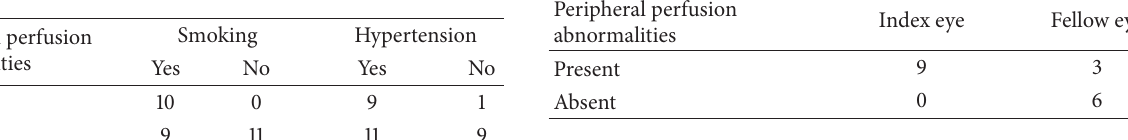
Table 2: Number of index eyes showing the presence of peripheral retinal perfusion abnormalities in subgroups of patients with a history of smoking and hypertension.